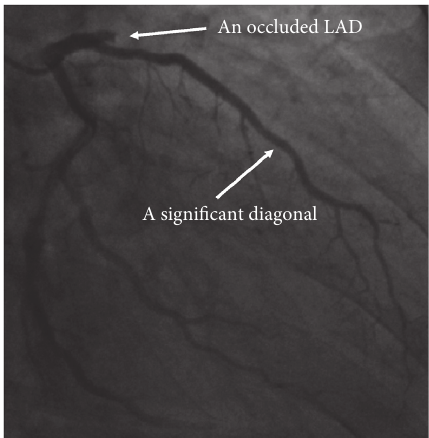
Figure 2: The need for adapting modification in the scoring of the LAD in the presence of a significant diagonal preceding the lesion. In the right anterior oblique 30 ° /caudal 20 ° view, the proximal LAD was totally occluded. A significant diagonal without a significant stenosis preceded the occlusive lesion. LAD � left anterior descending artery.